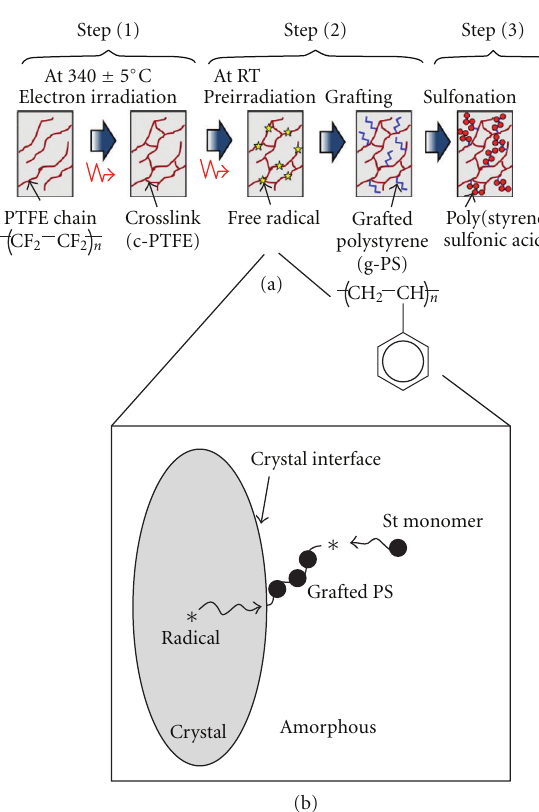
Figure 1: (a) A preparation procedure of polymer electrolyte membranes based on poly(tetrafluoroethylene), which is composed of three steps of (1) crosslinking, (2) grafting by Preirradiation and (3) sulfonation. (b) A schematic view of Preirradiation graft poly- merization with a crystalline domain and its interface. Long living radical is accumulated in a crystalline domain, whereas monomers access from an amorphous